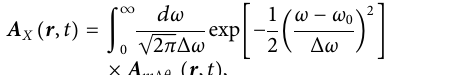
FIGURE 2 PMDsinplane-wave pulses. (A) Modulusofthepulsevector potential asafunctionofthedistance r fromthebeamaxisandtime t onalogarithmicscale. r 0 =11350 a.u.islabeledbythewhitedashedline. (B) Theprojectionofthepulse vector potential onthe vector potential Re{ A X ( r 0 , t )}. (D – F) PMDs of 1s, 2p x and 2p y states of a hydrogen atom at b = r 0 . PMD of 1s state is isotropic and centered at zero momentum. For2pstates, thereisanodal planeinPMDs.The structures ofPMDs inplane-wavepulses arecontributed onlybytheorbital. Theinsets in (D – F) present the 1s, 2p x and 2p y orbitals of a hydrogen atom. The units of physical quantities in fi gures are atomic units